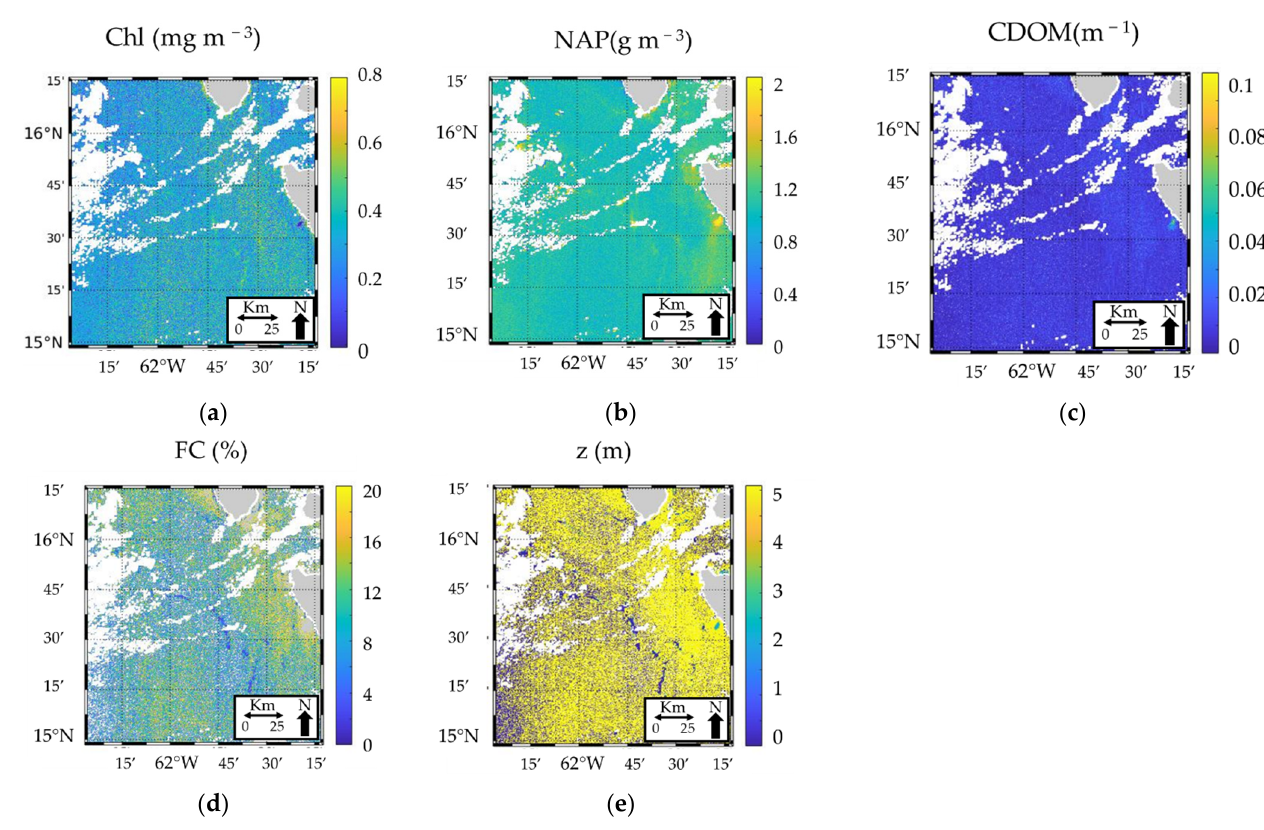
Figure 7. Spatial distribution of the bio-optical parameters retrieved by the SRT inversion applied to OLCI data acquired on 8 July 2017 over the study area (white square in Figure 2).